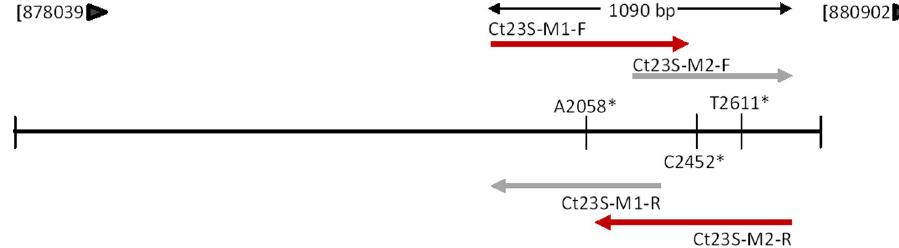
Fig 1. Chlamydia trachomatis 23S rRNA gene with primer sites. Chlamydia trachomatis 23S rRNA gene NC_000117.1 (878039–880902). � : The positions displayed with an asterisk are macrolide resistance associated mutations ( E . coli